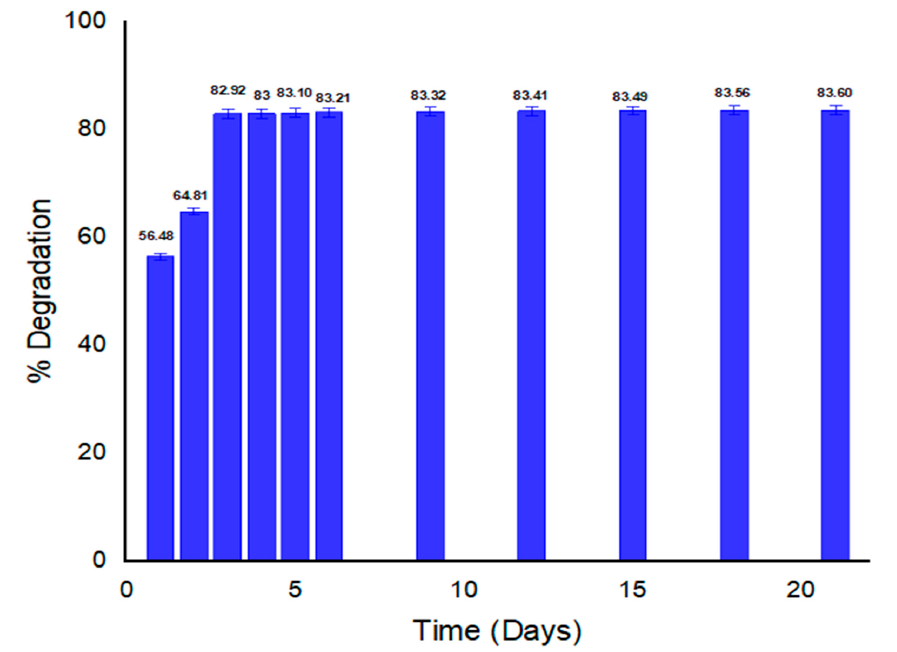
Figure 6. Effect of Incubation Time (Days) on Basic Orange 2 Dye % degradation.